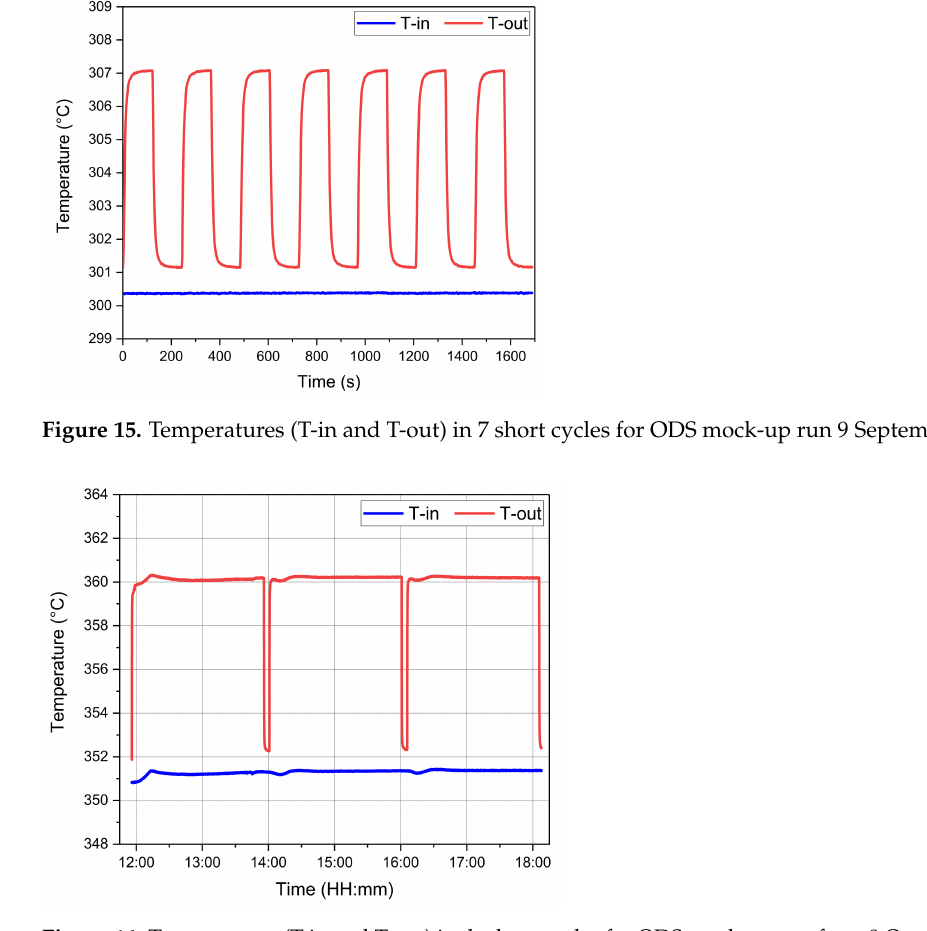
Figure 16. Temperatures (T-in and T-out) in the long cycles for ODS mock-up run from 8 October